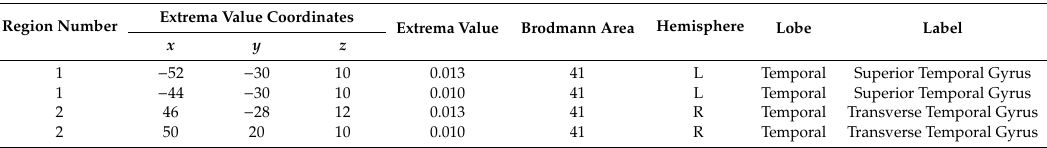
Table 2. Brain activity pattern in task-based map. Coordinates, extrema value, and corresponding Brodmann area, lobe, hemisphere, and regional labels are reported for each region resulting from the ALE